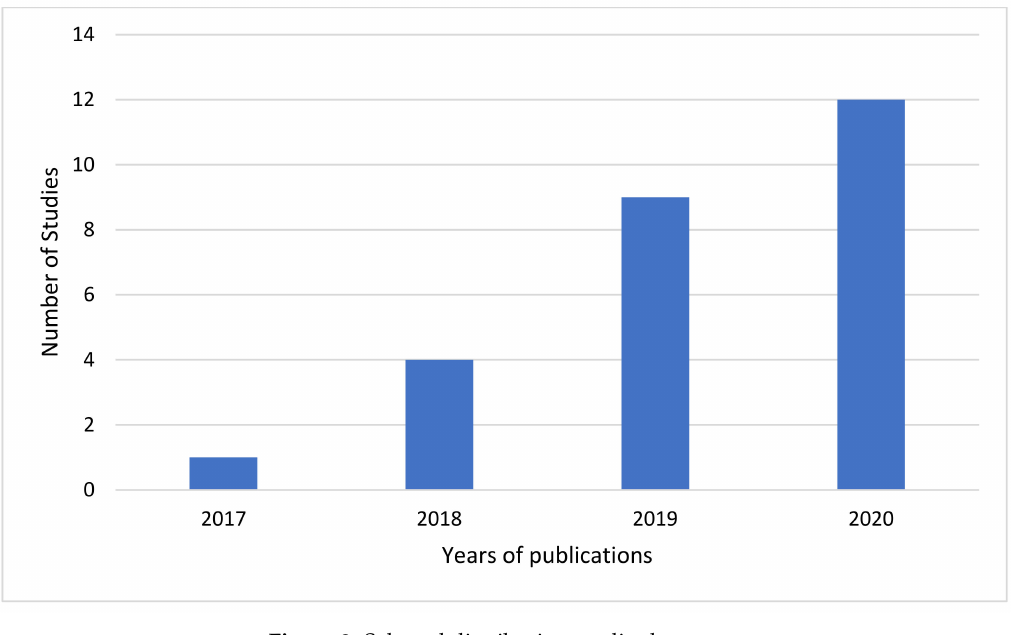
Figure 3. Selected distribution studies by years.